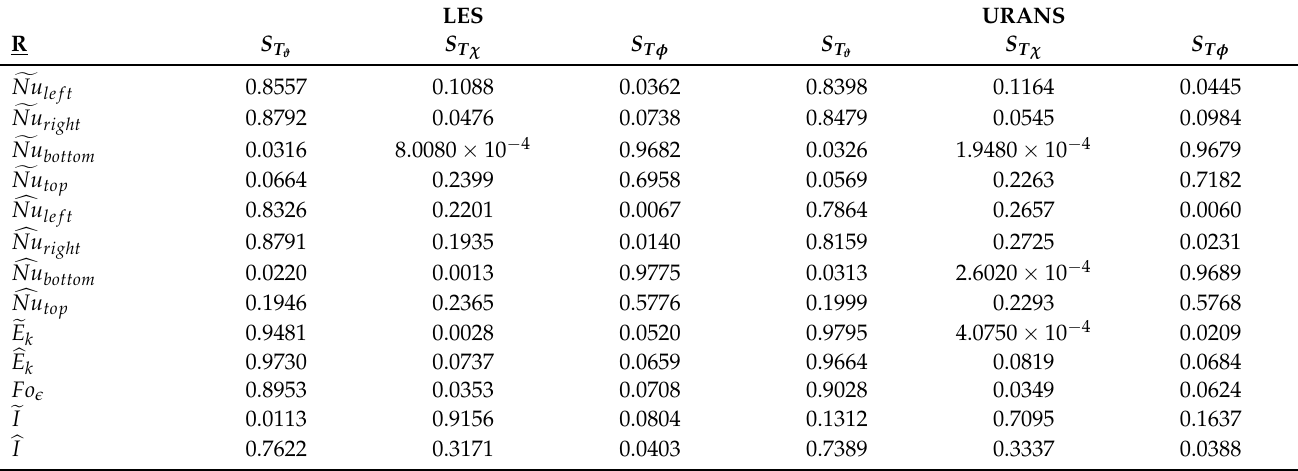
for the random response R qi